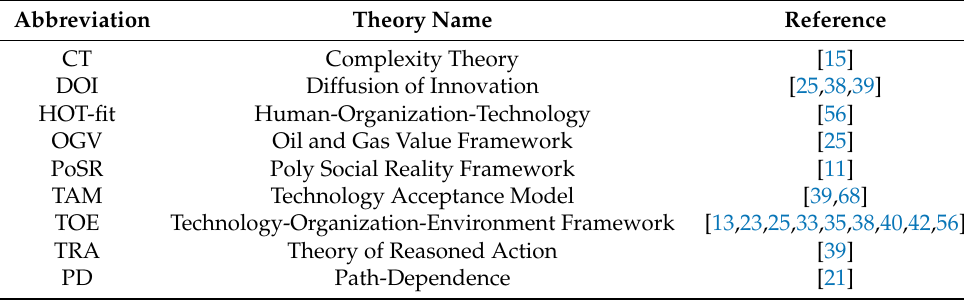
Table 3. The theoretical model used in IoT adoption at the organizational level.